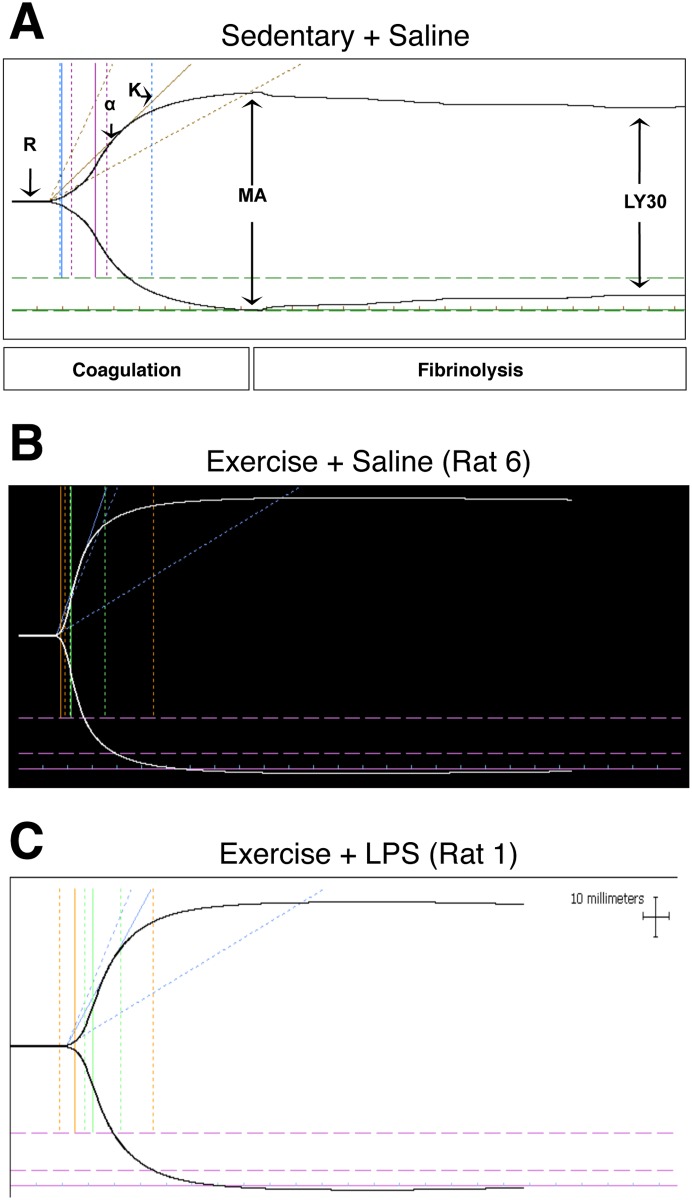
Exercise normalized thromboelastography parameters and tracings.Representative TEG trace revealing TEG parameters measured from blood collected from a Se+Saline control dam on GD 17.5 (A). TEG tracing from an Ex+Saline dam on GD 17.5 (B). TEG tracing from an Ex+LPS dam on GD 17.5 (C). R, time to clot formation; α, speed of clot propagation; K, rate of clot formation; MA, strength/stability of clot; CI, clotting index; LY30, percent clot dissolution in 30 min (%).